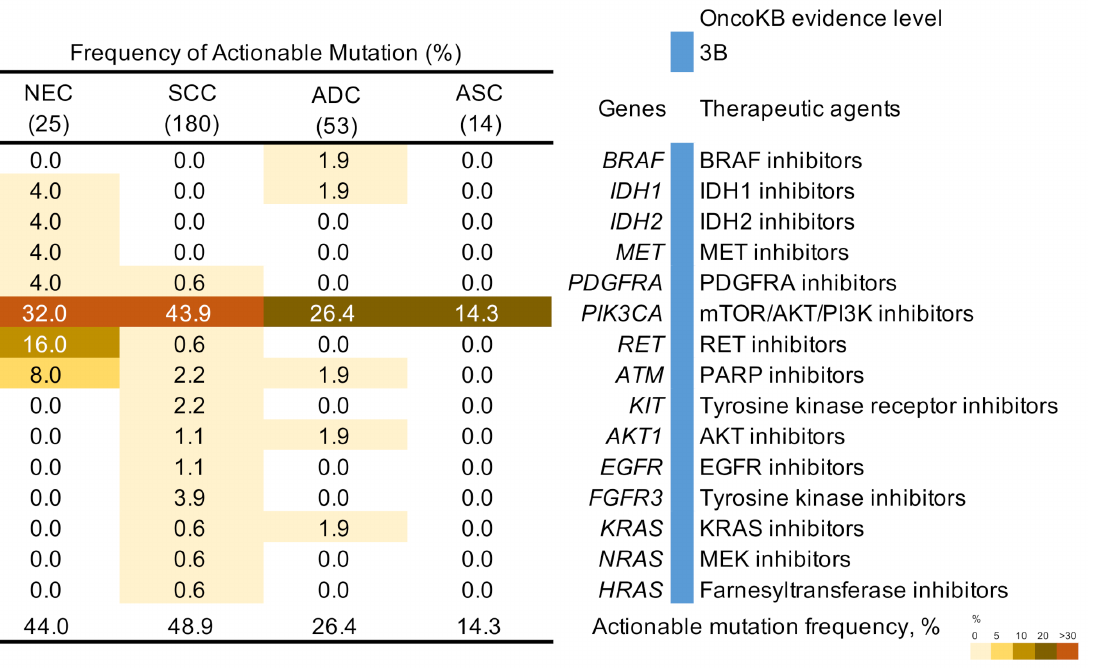
Figure 3. Frequency of actionable genetic mutations in cervical cancers. Percentages of samples mutated in individual tumor types are shown. NEC, neuroendocrine carcinoma; SCC, squamous cell carcinoma; ADC, adenocarcinoma; ASC, adenosquamous carcinoma.